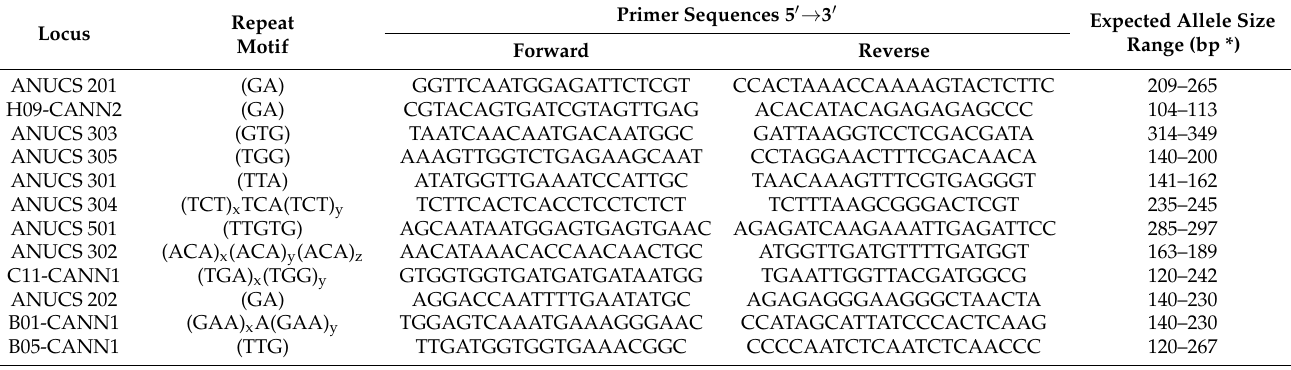
Table 4. Primer sequences and characteristics for 12 Cannabis sativa microsatellite